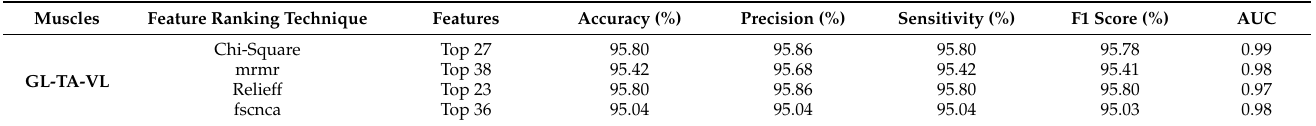
Table 5. Evaluation matrix for three-channel analysis for EMG data using different feature selection